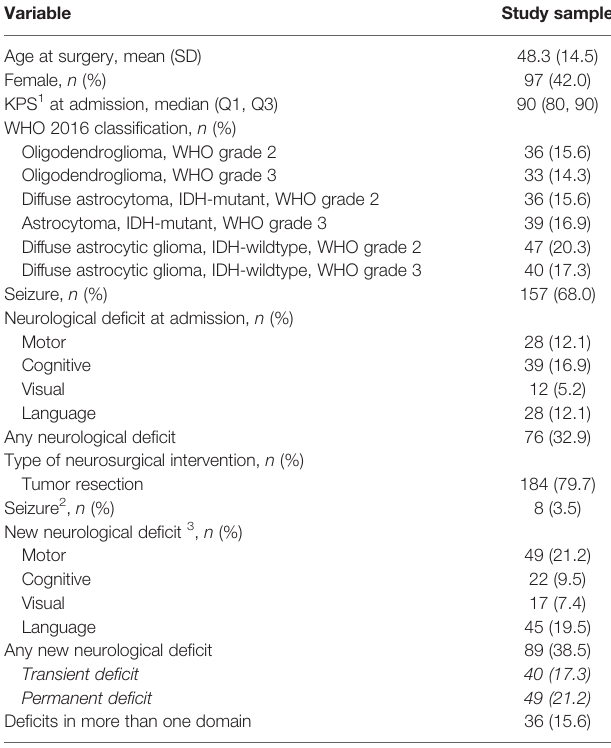
TABLE 1 | Patient characteristics and clinical variables ( N =